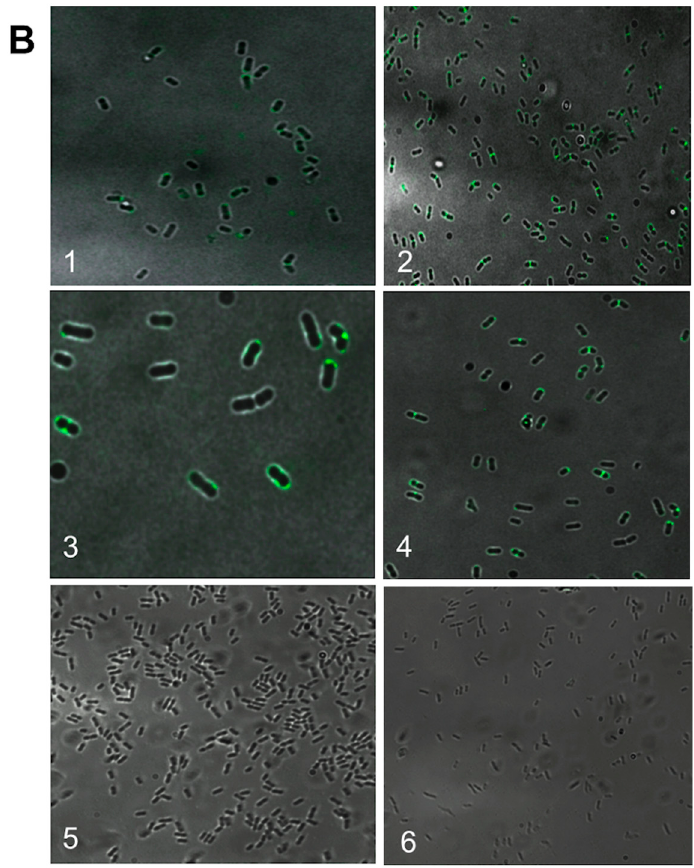
Figure 4. Surface localisation of chitosanase in L. plantarum cells analysed by flow cytometry ( A ) and immunofluorescence microscopy ( B ). The L. plantarum strains are denoted by different numbers in the flow cytometry histograms ( A ) and in the micrographs ( B ): pLp0373_CsnA_S ( A1 , B1 ); pLp0373_CsnA_L ( A2 , B2 ); p alr Lp0373_CsnA_S ( A3 , B3 ); p alr Lp0373_CsnA_L ( A4 , B4 ); L. plantarum WCFS1 harboring an empty vector pEV (red line in A1 – A2 ; B5 ) and L. plantarum TLG02 (black line in A3 – A4 ; B6 ) were used as negative controls.